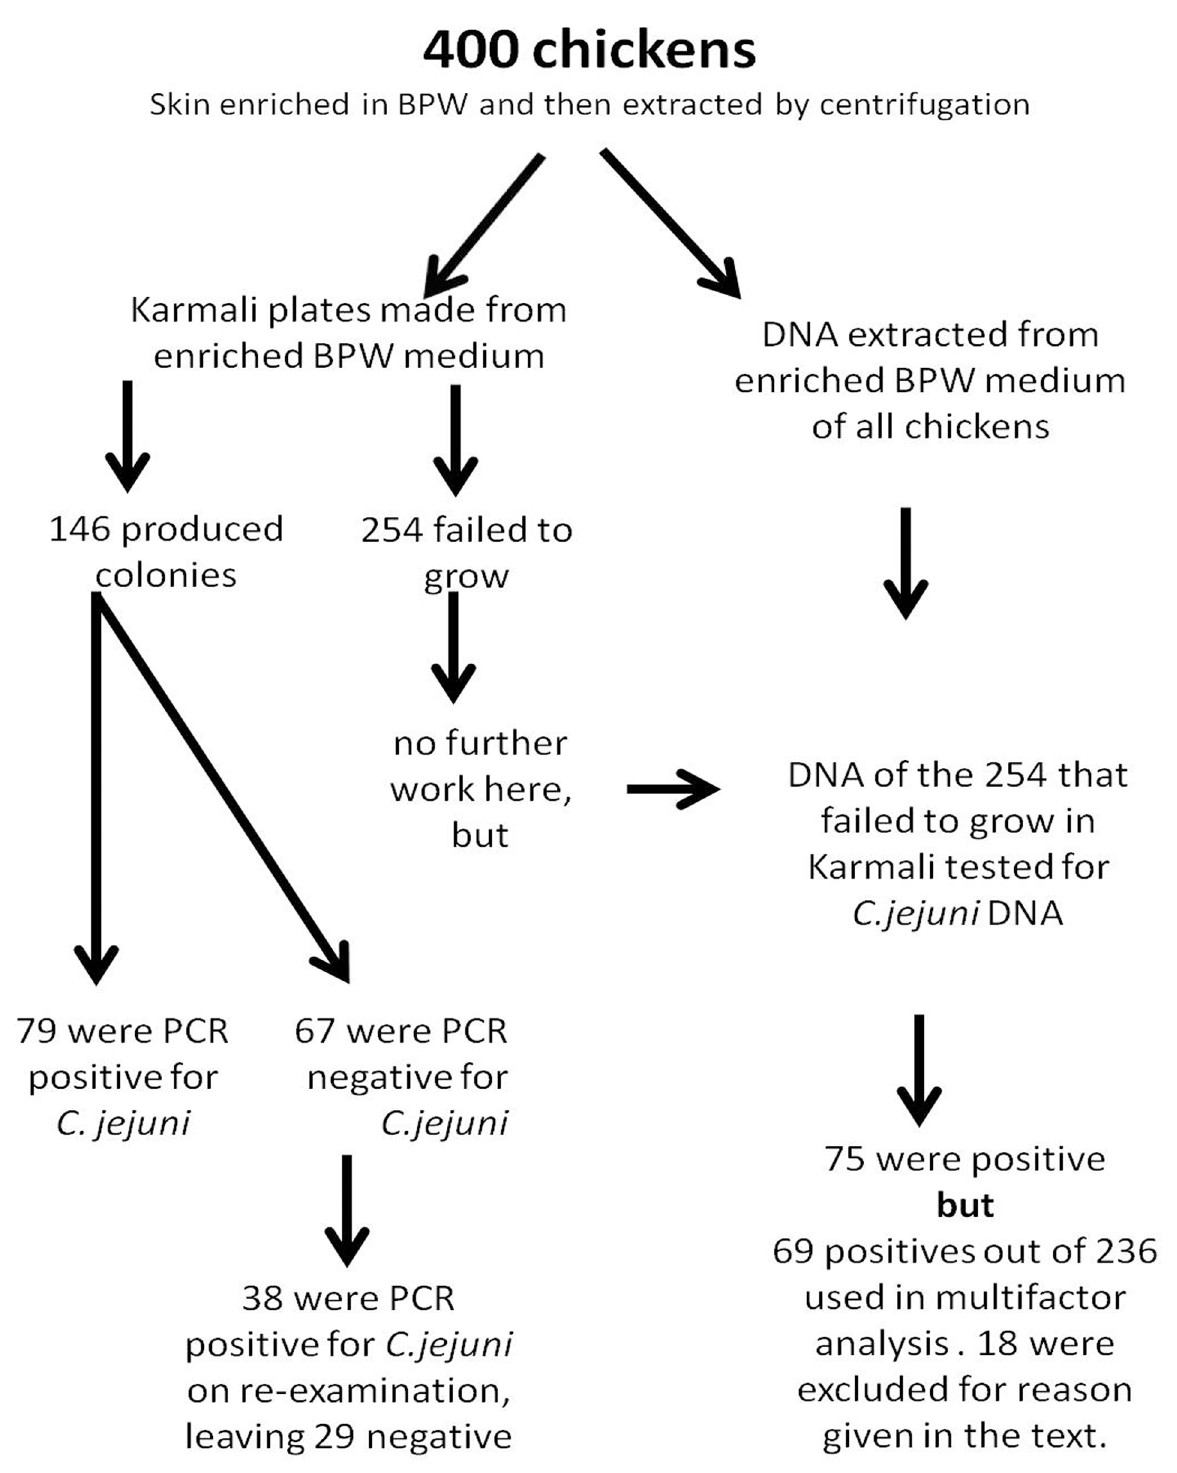
Fig 1. Schematic diagram of the stages in the analysis of samples. The number of samples at each stage are shown.